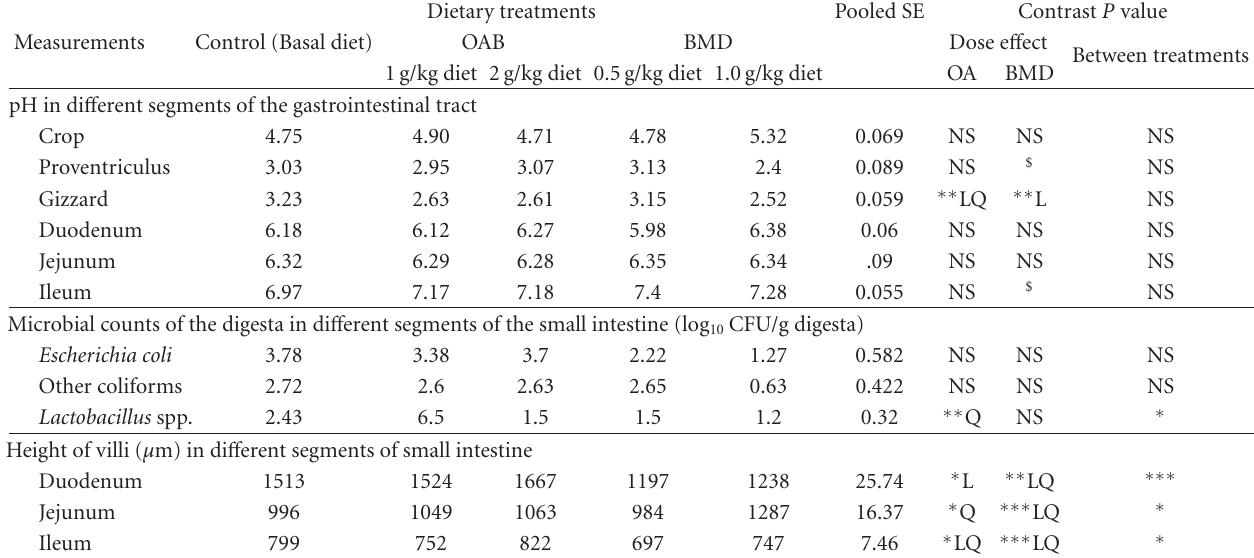
Table 4: E ff ect of feeding organic acid blend (OA) and bacitracin methylene disalicylate (BMD) at di ff erent dose levels on pH of di ff erent segments of the gastrointestinal tract, microbial counts in the digesta contents of the small intestine and length of the villi in di ff erent segments of the small intestine †